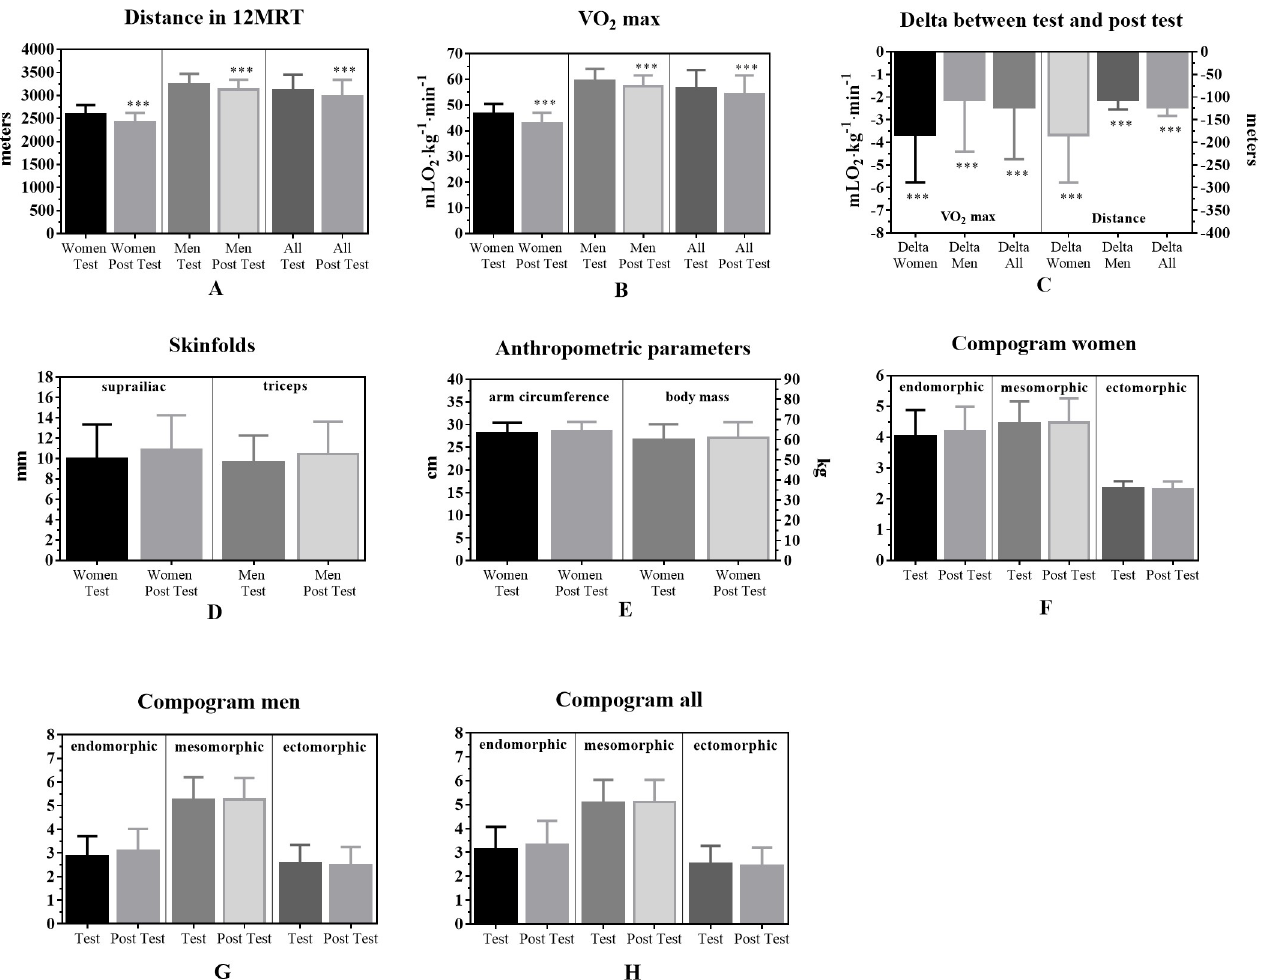
Fig 2. Changes in VO 2 max and anthropometric parameters before and after 12 weeks without mandatory physical training. 12MRT: 12-minute race test; mLO 2 � Kg –1 � min –1 : milliliters of oxygen per kilogram of body mass per minute; mm: millimeters; cm: centimeters; kg: kilograms; ��� : p < 0.002.